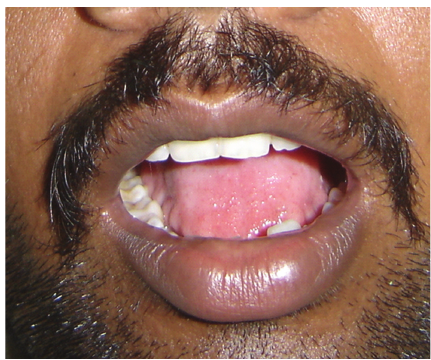
Figure 9: Preoperative picture.